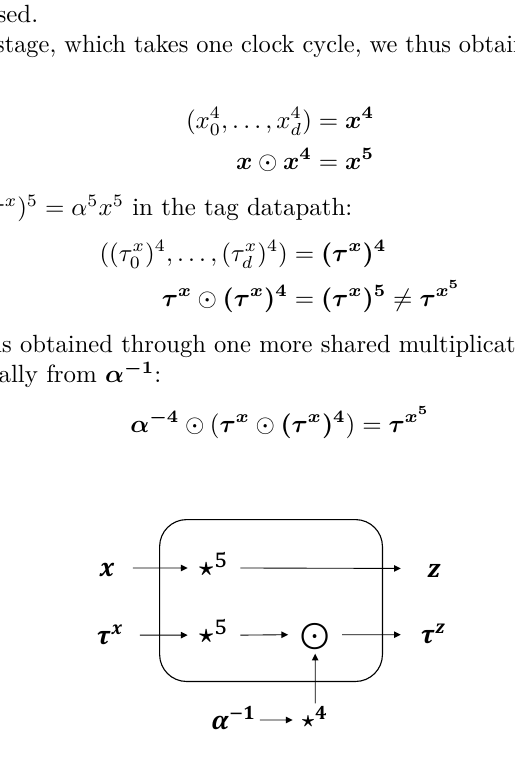
Figure 4: Obtaining the value and tag shares of z = x